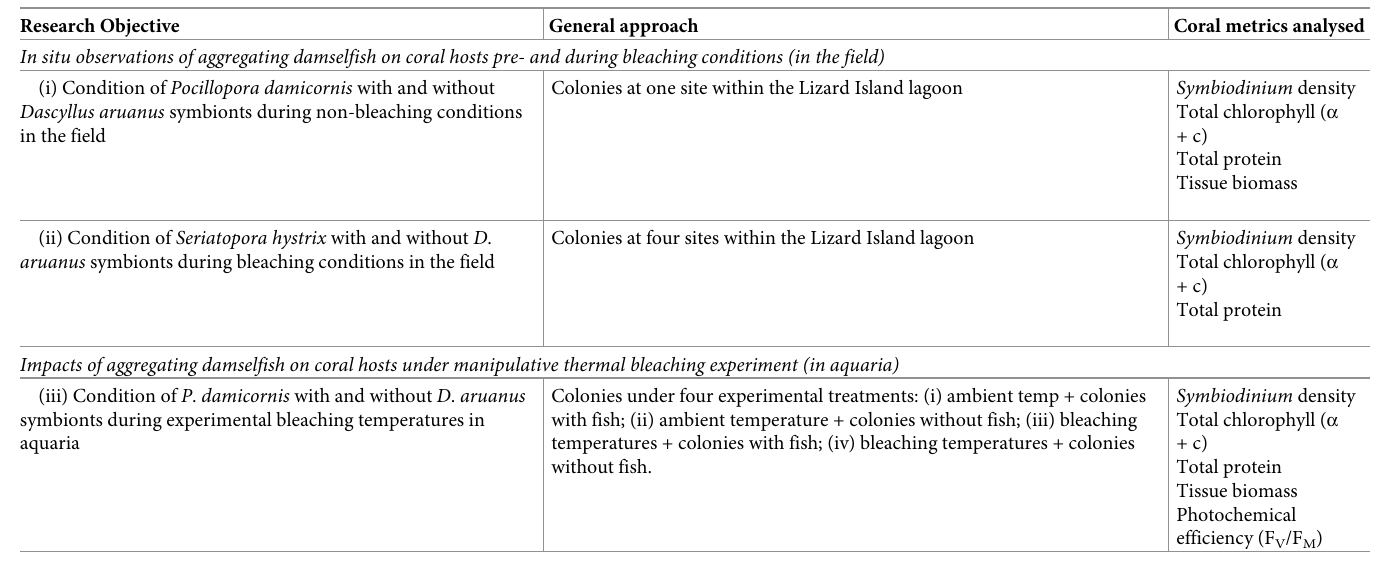
Table 1. Summary of the research objectives of this study, the general approach, and coral metrics used to investigate each